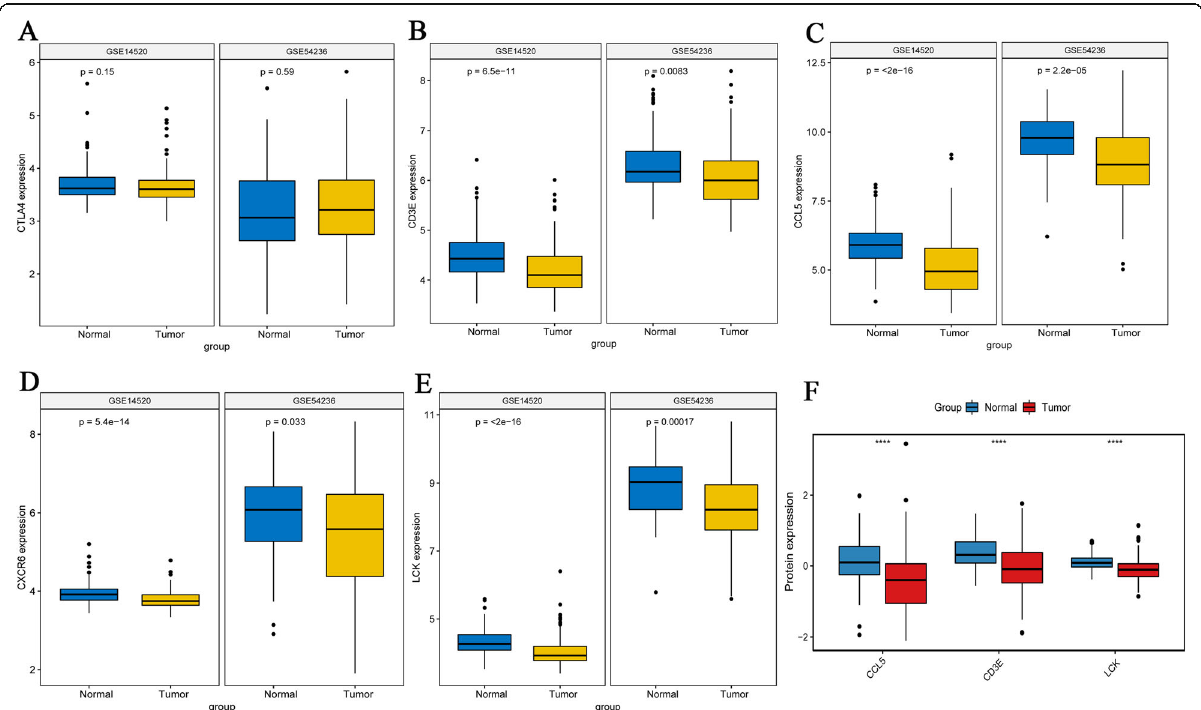
Fig. 8 Differential expression of CTLA4, CD3E, CCL5, CXCR6 and LCK in HCC samples and adjacent non-tumor samples. A - E Differential expression of genes, including CTLA4 ( A ), CD3E ( B ), CCL5 ( C ), CXCR6 ( D ) and LCK ( E ) in HCC samples and adjacent non-tumor samples in the GSE14520 and GSE54236 datasets. F Differential expression of proteins, including CD3E, CCL5 and LCK in HCC samples and adjacent non-tumor samples from the Proteomic Data Commons data set. Normal and Tumor indicate adjacent non-tumor samples and HCC samples, respectively. P < 0.05 was considered to indicate a statistically significant difference. ****, P < 0.0001. HCC: hepatocellular